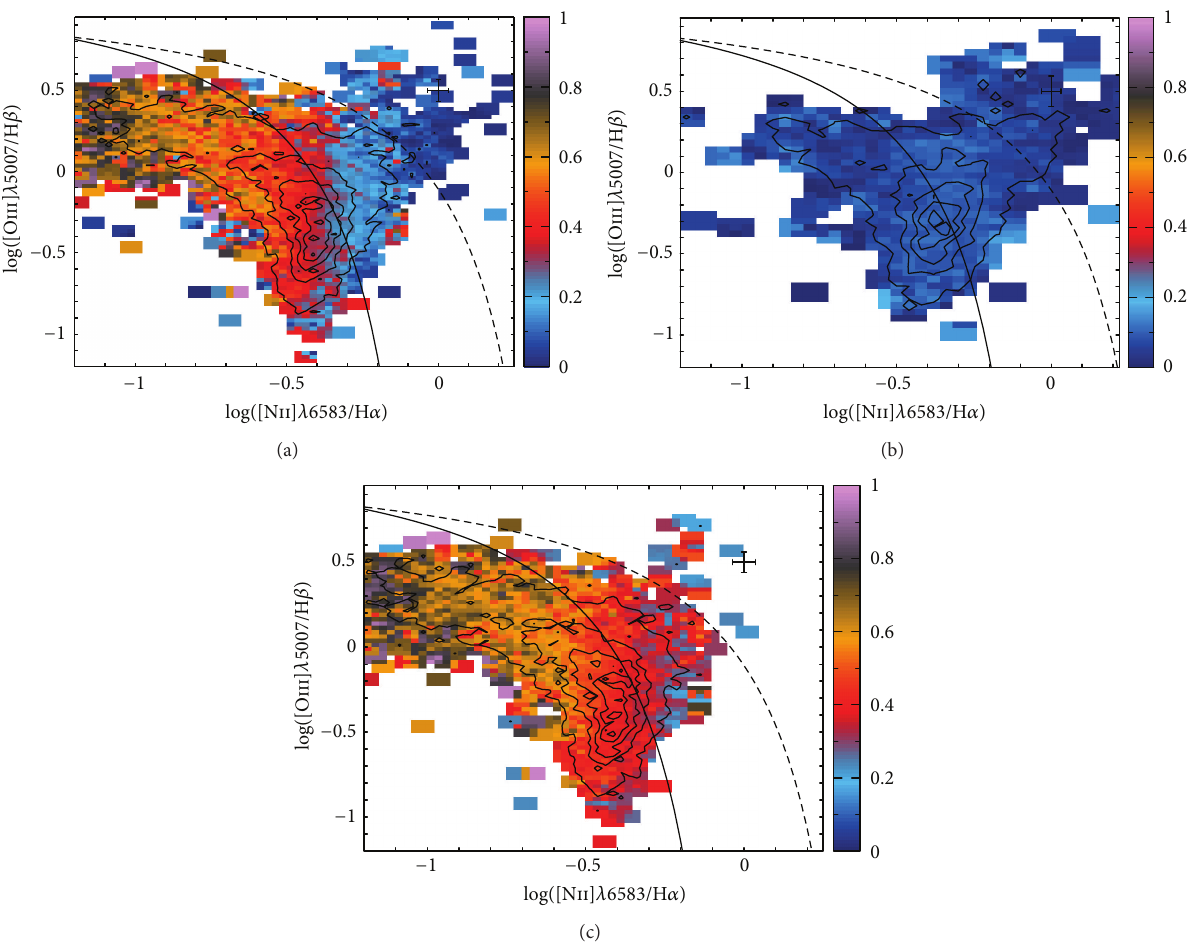
Figure 3: (a) [Oiii] 𝜆 5007/H 𝛽 versus [Nii] 𝜆 6583/H 𝛼 diagnostic diagram for the ∼ 7000 ionized regions described in the text. The contours show the density distribution of these regions with the diagram plane, with the outermost contour enclosing 95% of the regions, and each consecutive one enclosing 20% less regions. The color indicates the fraction of young stellar population in the underlying continuum. (b) The same diagnostic diagram restricted to those ionized regions with less than a 20% of young stellar population ( ∼ 1800 regions). (c) The same diagnostic diagram restricted to those ionized regions with more than a 20% of young stellar population ( ∼ 5800 regions). In all the panels, the solid- and dashed-line represent, respectively, the Kauffmann et al. [26] and Kewley et al. [27] demarcation curves. They are usually invoked to distinguish between classical star-forming objects (below the solid line) and AGN powered sources (above the dashed line). Regions between both lines are considered intermediate